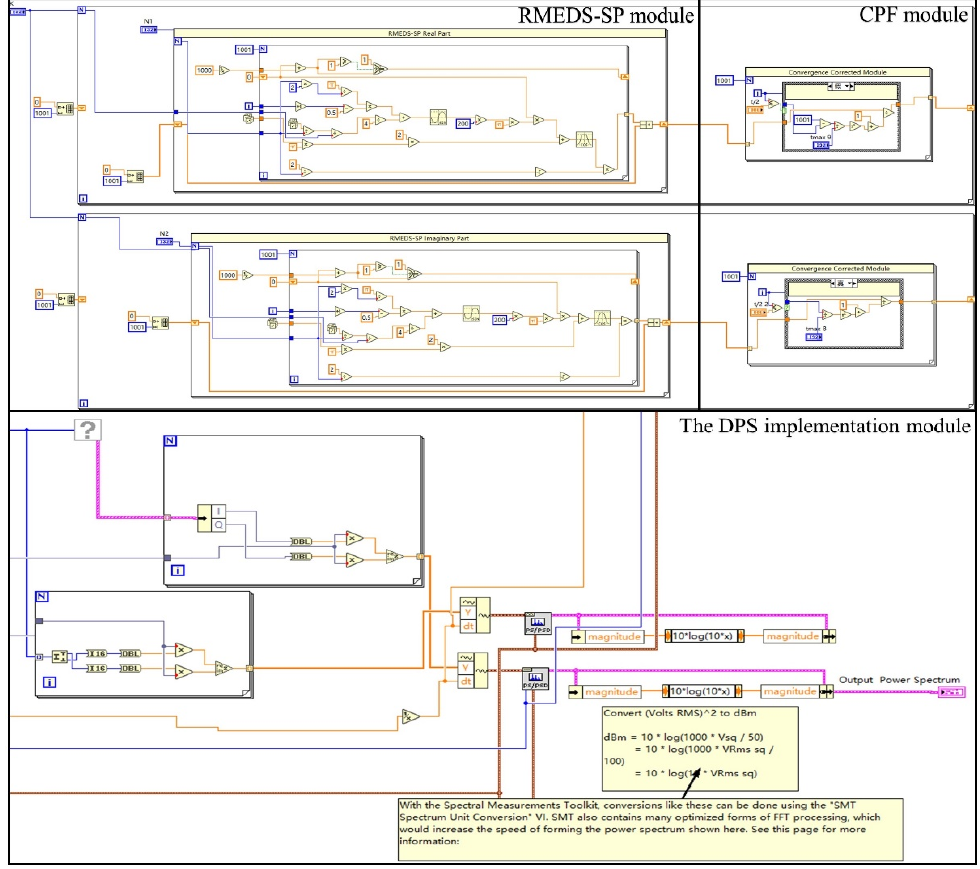
Figure 15. Framework of hardware implementation of RMEDS-SP.